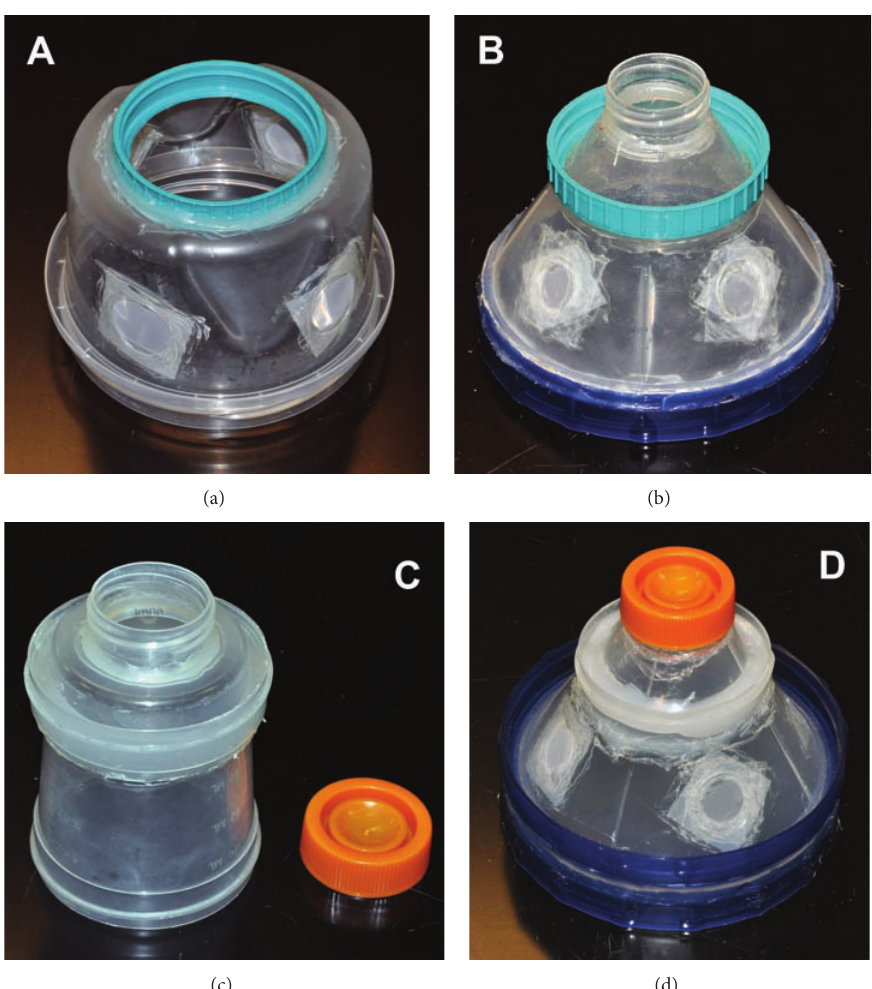
Figure 2: Basic cage system modular components. (a) Cage bottom, (b) cage cover, (c) connection cup, and (d) cage series